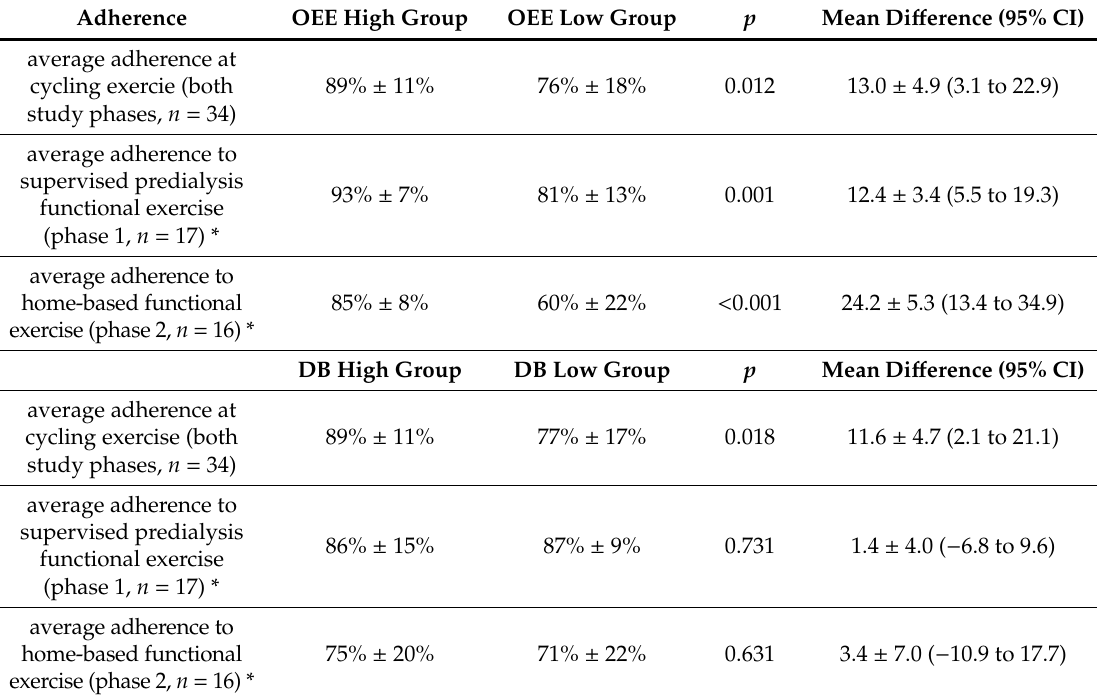
Table 5. Di ff erences between adherence to exercise programs in the low and high group based on the baseline score in